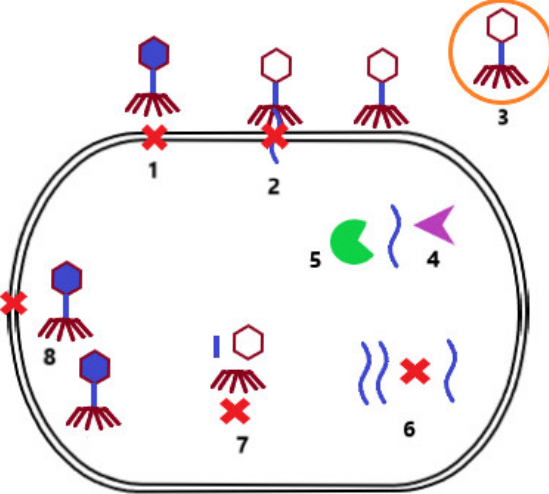
Figure 2. Mechanisms of bacterial resistance to phage infection. Prevention of phage adsorption to the surface of bacterial cells due to alteration of the surface receptor or production of protective surface polysaccharides ( 1 ). Prevention of phage NA injection by modification of inner membrane proteins ( 2 ). Reducing the number of free infectious bacteriophage particles by producing membrane vesicles ( 3 ). Degradation of phage NA by the restriction modification system ( 4 ) or the CRISP-Cas system ( 5 ). Prevention of phage NA replication by secondary bacterial metabolites ( 6 ). Inhibition of the assembly of phage particles by blocking terminase or scattering envelope proteins ( 7 ). Limitation of phage particle production by induction of cell death ( 8 ).